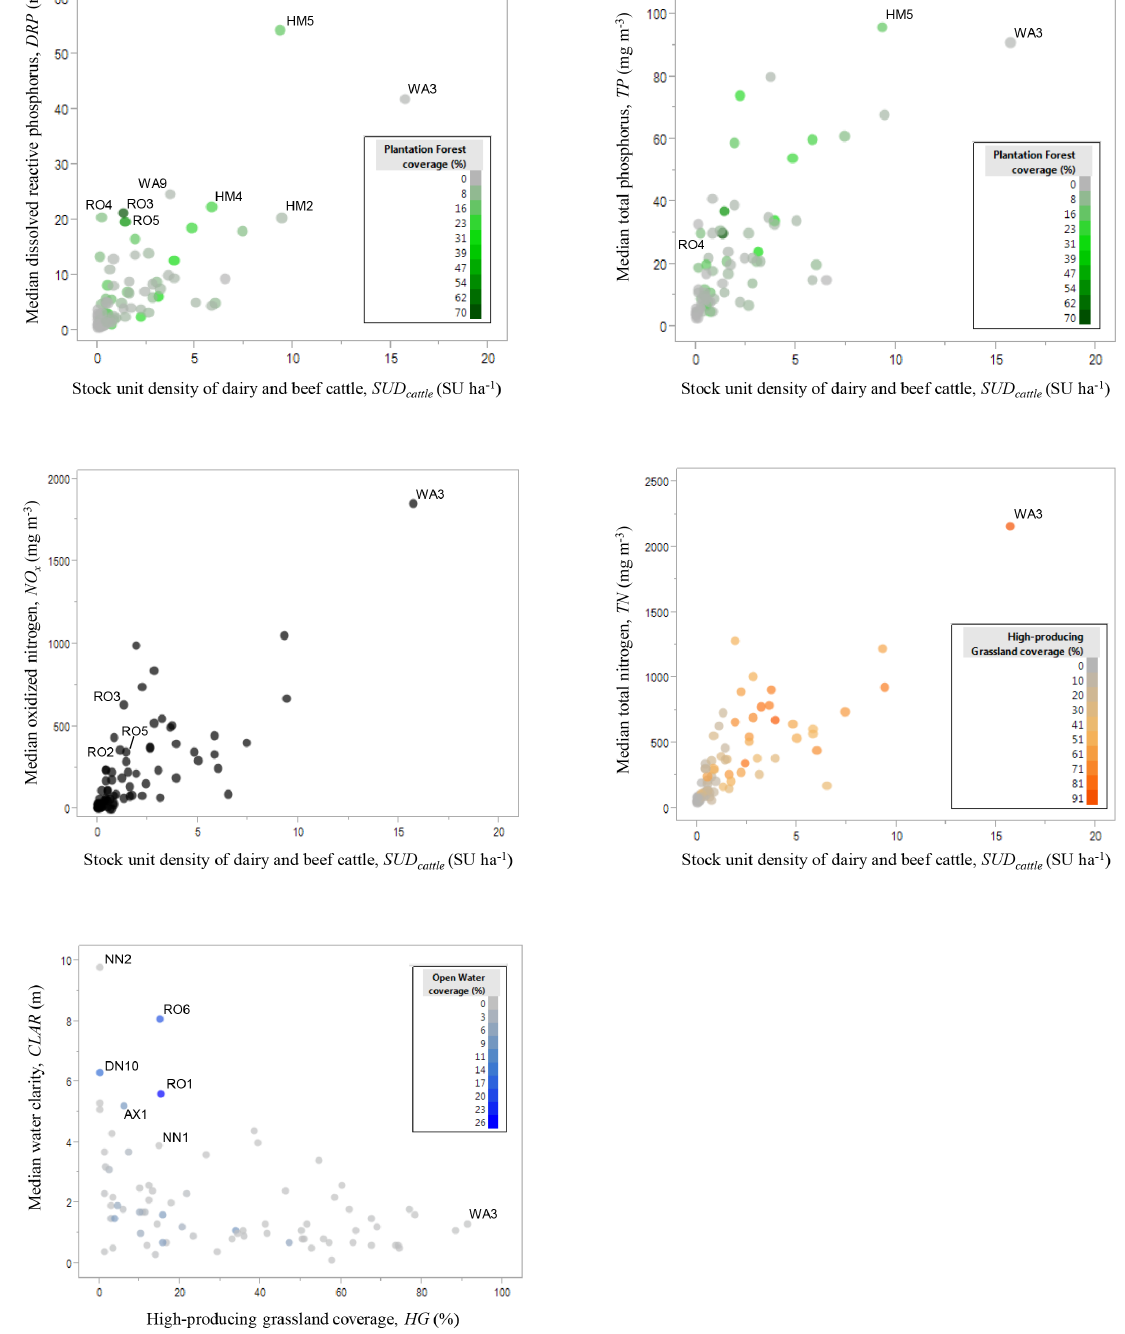
Figure 5. Multivariate relationships between major water quality variables (median value for each site) and land use variables. For each plot, the primary explanatory variable from the stepwise regression (Table 8) is the x axis, with bubble color representing the secondary explanatory variable. Note that oxidized nitrogen (NO x ) did not have a secondary explanatory variable. Selected catchments discussed in the text are